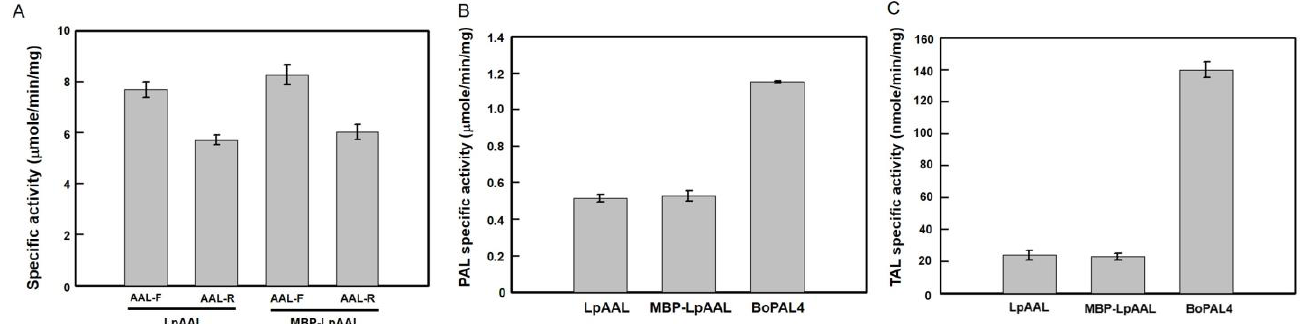
Figure 7. Comparison of specific activities in LpAAL, MBP-LpAAL, and BoPAL4. ( A ) Specific AAL-F